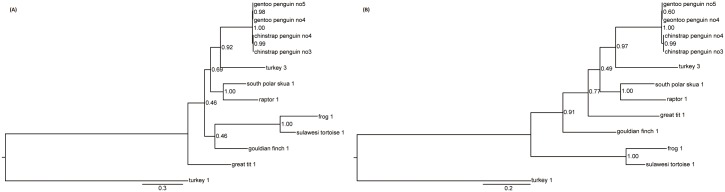
Phylogenetic relationships within the genus Siadenovirus based on partial DNA polymerase sequences (a) inferred from nucleotide alignment and (b) from amino acid alignment.The phylogenetic tree was obtained with a Bayesian inference of phylogeny by the MrBayes v3.1.2 software.